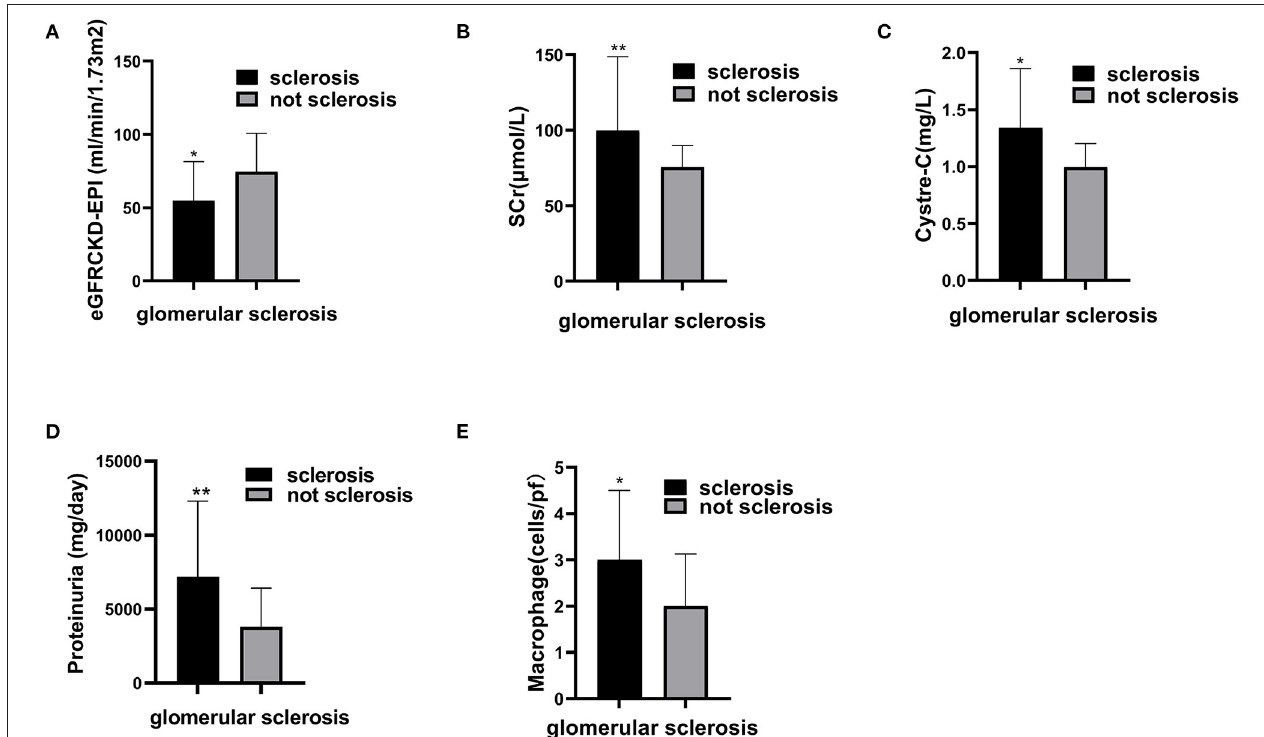
FIGURE 3 | The correlation between glomerular sclerosis and clinical features and macrophages in glomeruli. Compare estimating glomerular filter rate (A) , serum creatinine (B) , Cystre-C (C) , Proteinuria (D) , and macrophage (E) between patients with glomerular sclerosis and patients without glomerular sclerosis. Significant correlation * p < 0.05, ** p <